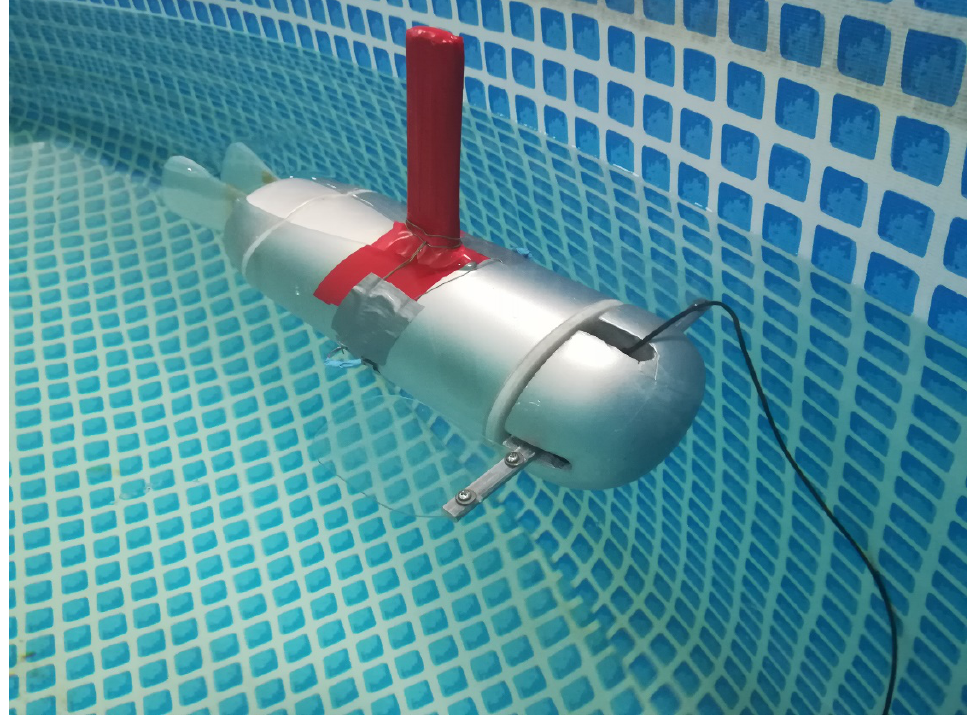
Figure 1. Model of the BUV mini CyberSel [own